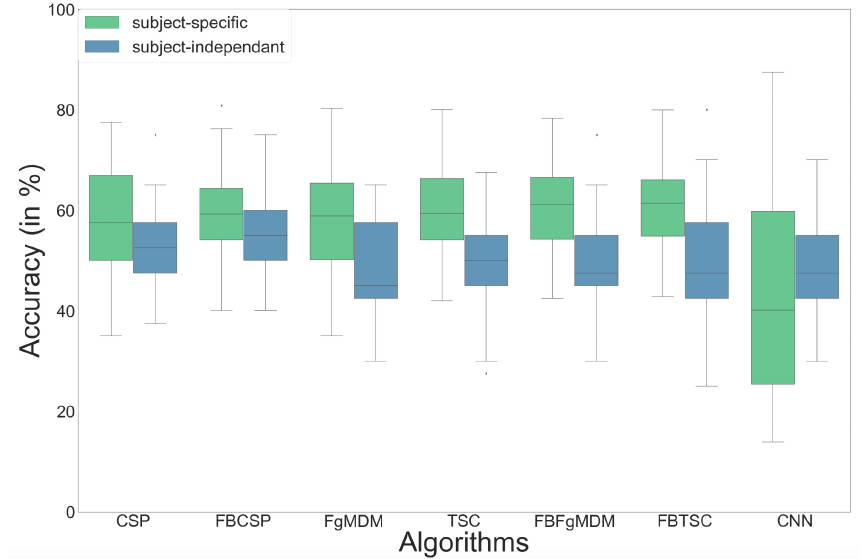
Figure 9. Classification accuracy of each algorithm on the valence data, in both subject-specific and subject-independent calibrations.